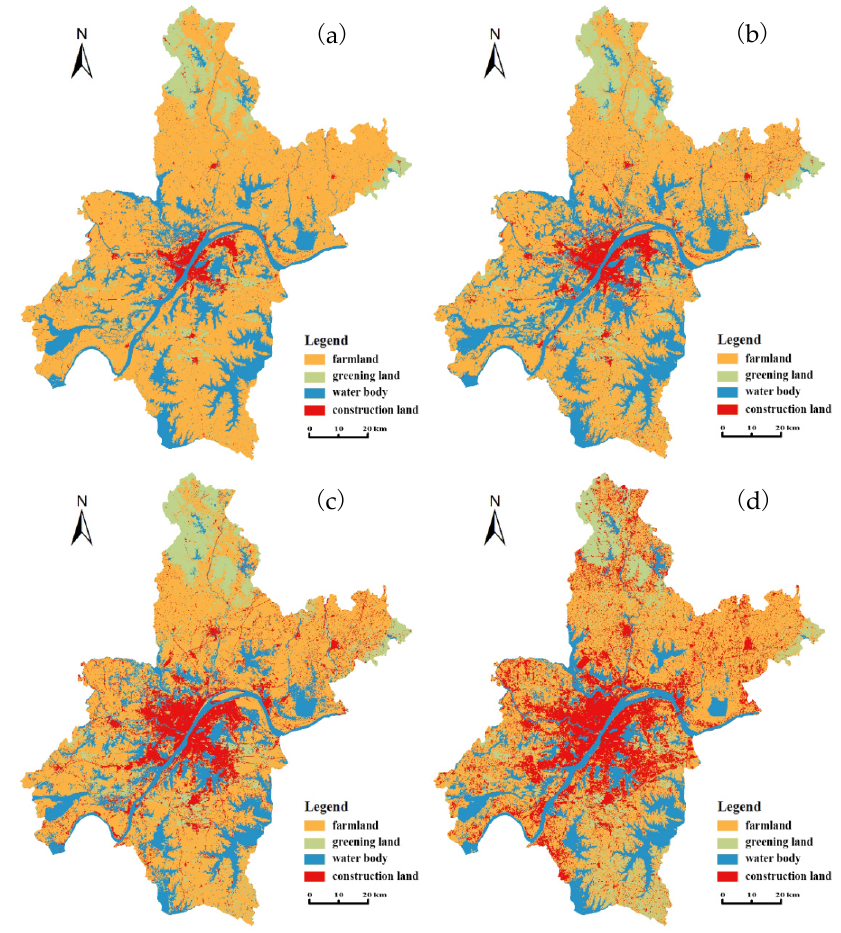
Figure 2. LULC distribution maps of Wuhan for ( a ) 1987, ( b ) 1996, ( c ) 2007 and ( d ) 2016.